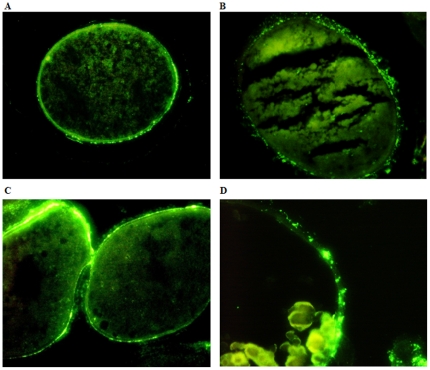
Photomicrographs of immunostained sections of colonized tick oocytes.LVS colonized the tunic propria and shell of D. variabilis oocytes. (A & C) 400× magnification. (B& D) 500× magnification.